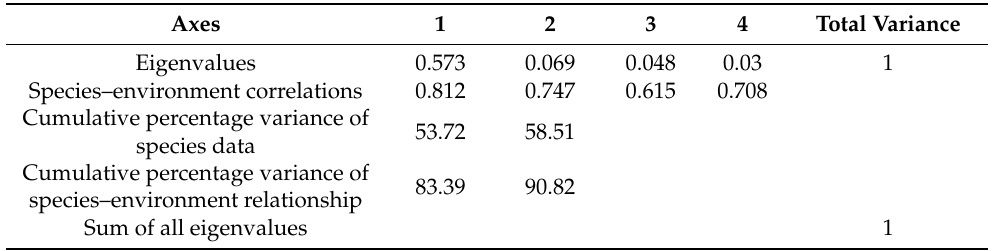
Table 2. Summary of RDA analyses with environment variables explaining phytoplankton assem- blage after the flooding of Huayanghe